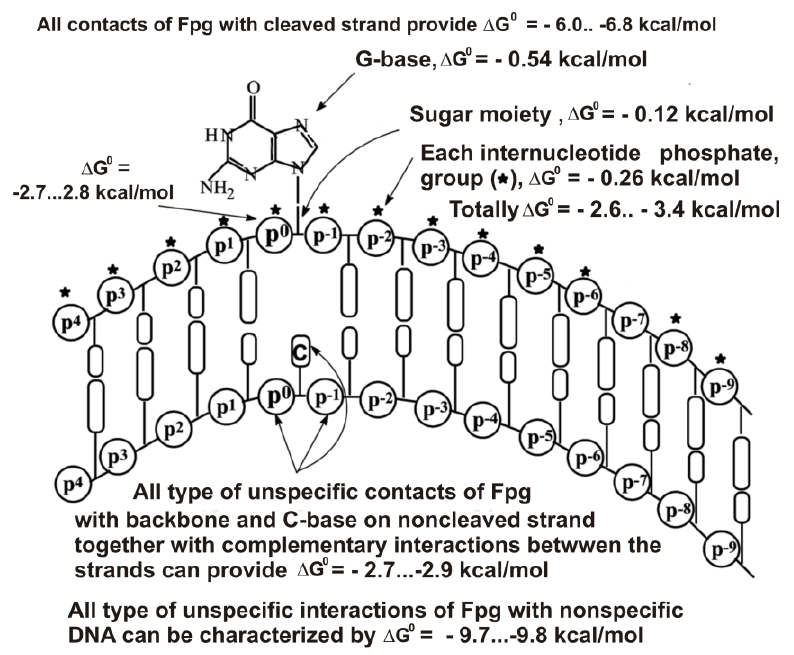
Figure 5. The thermodynamic model of E. coli Fpg interaction with unspecific DNA. All types of unspecific contacts are shown on the Panel [57]. The enzyme forms weak additive contacts only with internucleoside phosphate groups of DNA and there are contacts only of the active center with one of the DNA bases.